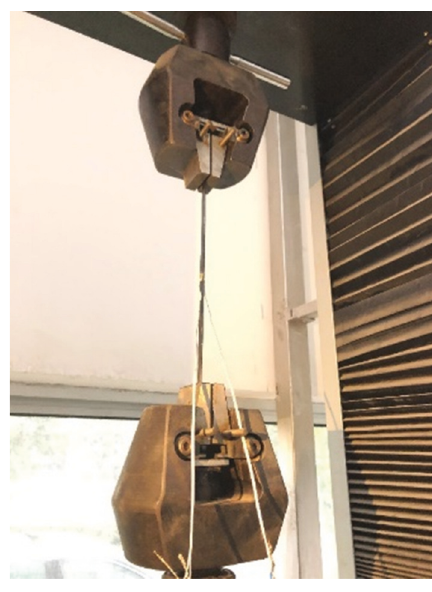
Figure 8: Failure picture of